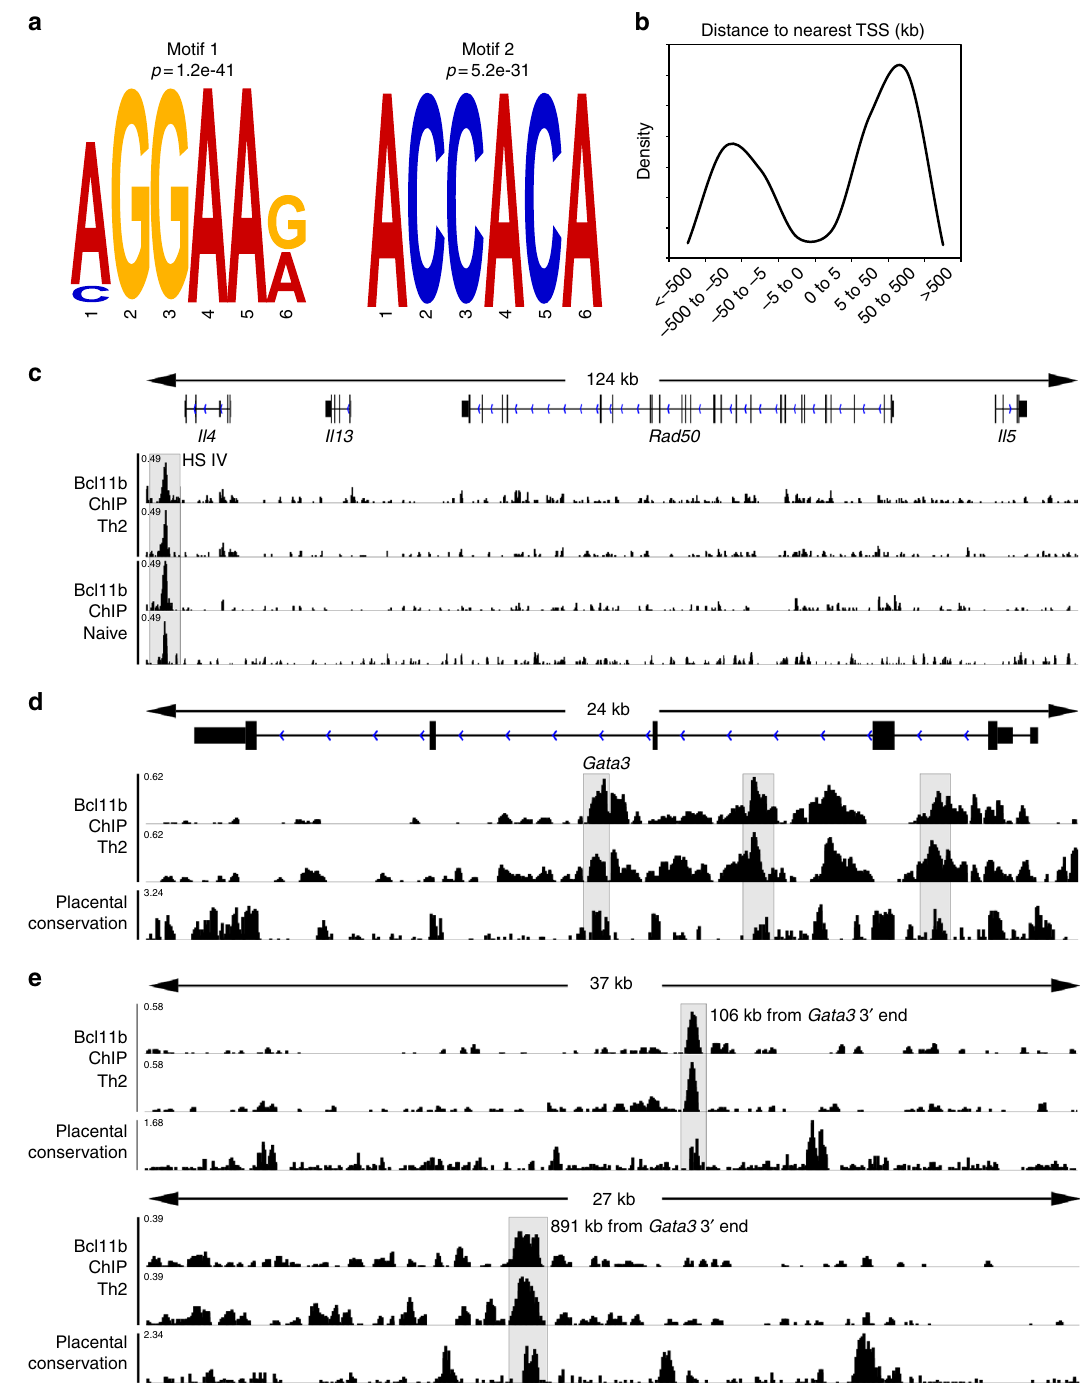
Fig. 5 Bcl11b binds at the Gata3 locus and downstream and at the Il4 HS IV silencer but not at the Th2-LCR or Th2-cytokine promoters in CD4 + T-cells. a The top two Bcl11b binding motifs discovered using MEME-ChIP motif analysis software from Bcl11b ChIP-seq of CD4 + T-cells from WT mice infected ( n = 2) with H. polygyrus bakeri . b Density distribution of Bcl11b binding relative to the nearest transcription start site (TSS). Data obtained from Genomic Regions Enrichment of Annotations Tool (GREAT). c – e Integrative Genomics Viewer visualizations of Bcl11b ChIP-Seq tracks at the Th2 cytokine locus (c, Il4 HS IV silencer is highlighted), Gata3 ( d intronic regions are highlighted), and ( e conserved non-coding binding sites downstream of Gata3 are highlighted) from naive ( n = 2) ( c ) or helminth-infected ( n = 2) ( c – e ) mice. ChIP-Seq track scale bar normalized to sequences per million reads